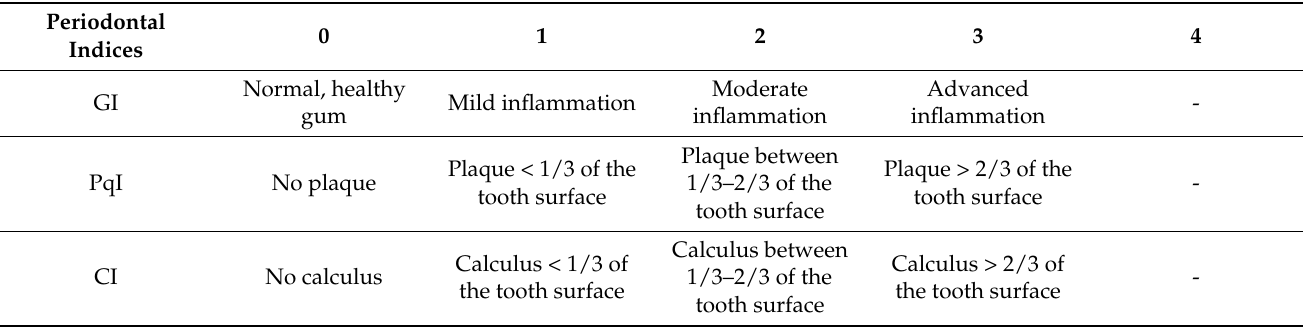
Table 1. Periodontal indices